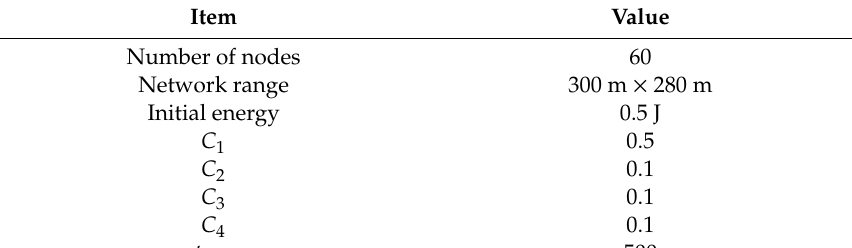
Table 3. Parameter-setting in case study.